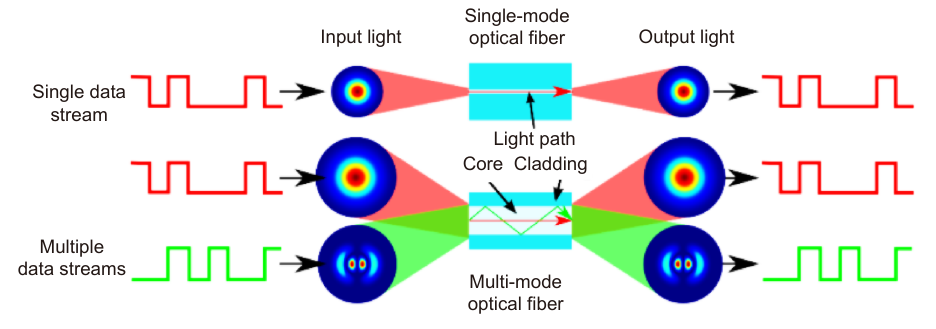
Fig. 10 | The operation principle of MDM. The scheme is adapted from ref. 90